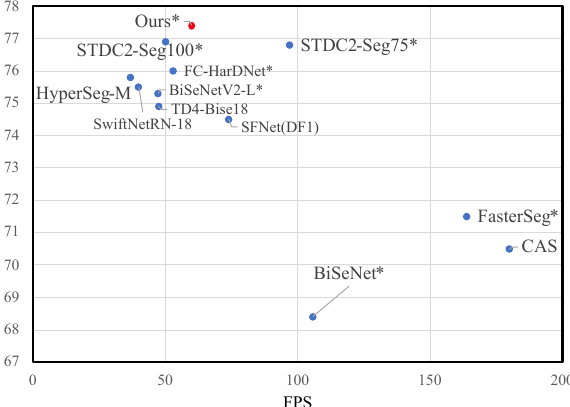
Figure 1. Speed-accuracy performance comparison on the Cityscapes test set. The red dot indicates our work while the blue dot indicates other methods. Our approach achieves the best speed-accuracy trade-off. The corresponding speed is measured using tensorrt acceleration if the method is marked with